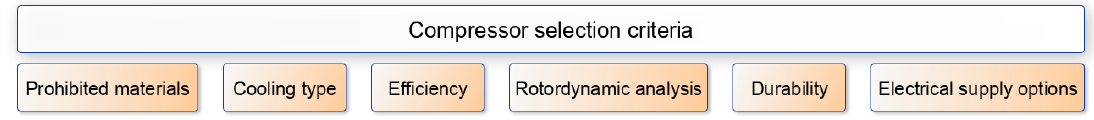
Figure 10. Compressor selection criteria.